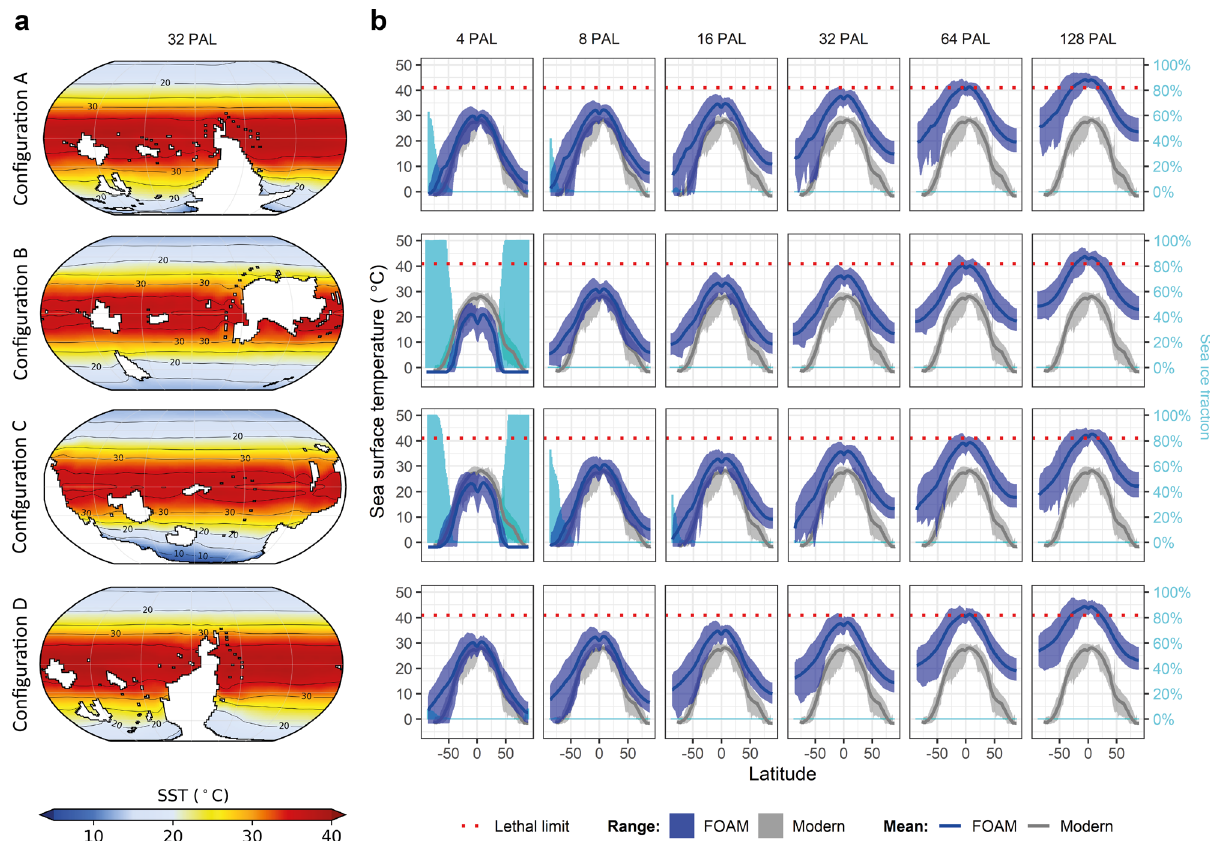
Fig. 4 FOAM GCM simulations of early Cambrian sea-surface temperatures for each continental con fi guration (A – D) with present-day orbital parameters. a Maps of simulated SST for con fi gurations A – D at 32 PAL p CO 2 . b Zonally averaged model (dark blue) SST annual mean and seasonal variation for each con fi guration and p CO 2 forcing, with comparable present-day SST values (grey) from ref. 72 , and lethal temperature limit for animals of 41 °C, following ref. 50 , plotted with mean zonal sea-ice cover (light blue). The sea ice cover represents the percentage of the ocean that is covered by sea ice (yearly average). p CO 2 levels relative to PAL ( = 280